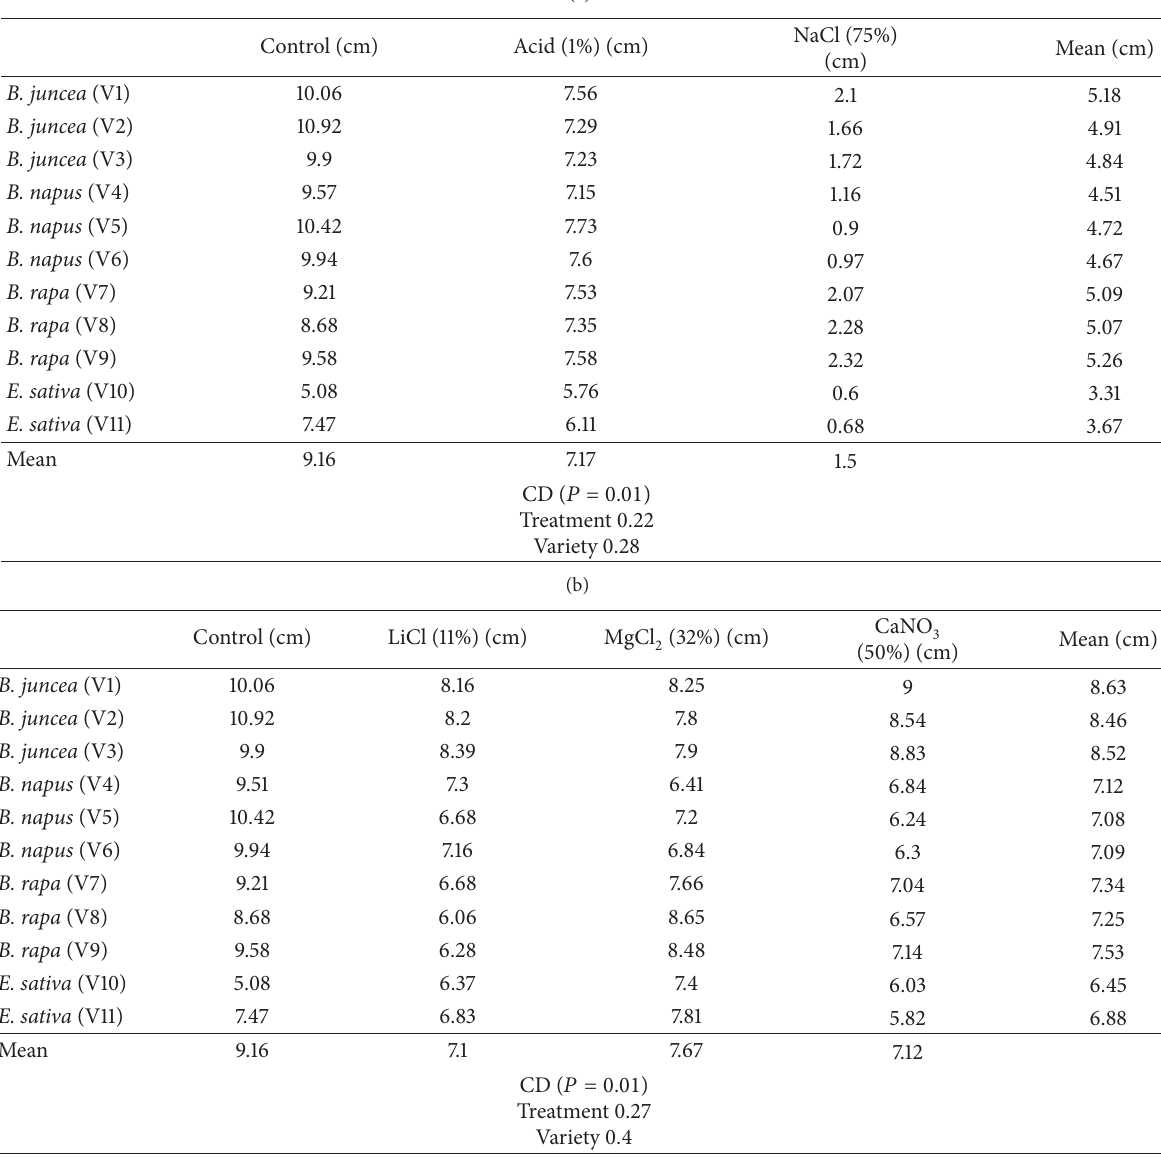
Table 3: Effect of high and low (a) and intermediate (b) RH on shoot length of various accessions of Brassica spp. and Erucasativa